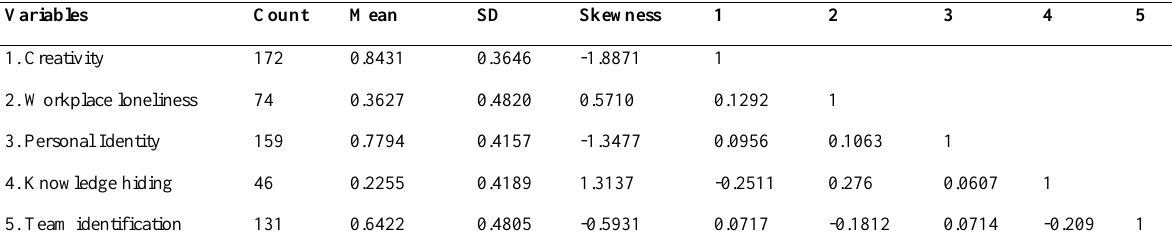
Table 1: Mean, Standard Deviation (SD) and